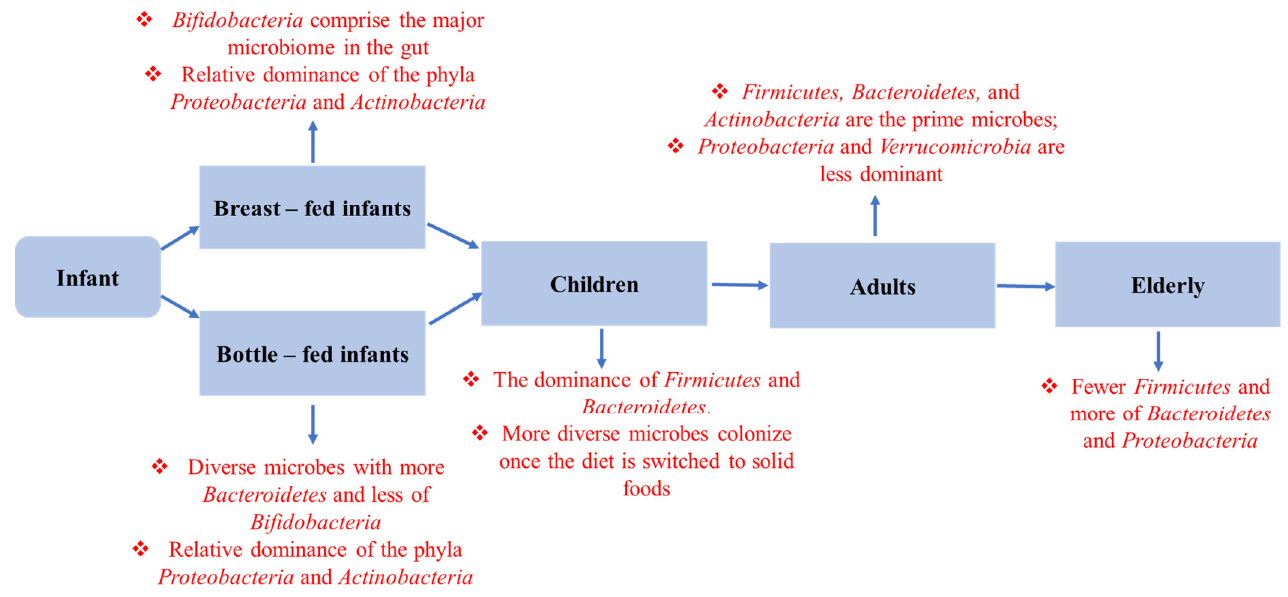
Figure 5. Composition of gut microbiota in the healthy aging process. The age-related sequential change in gut microbiota composition and metabolic function from infant to centenarian.